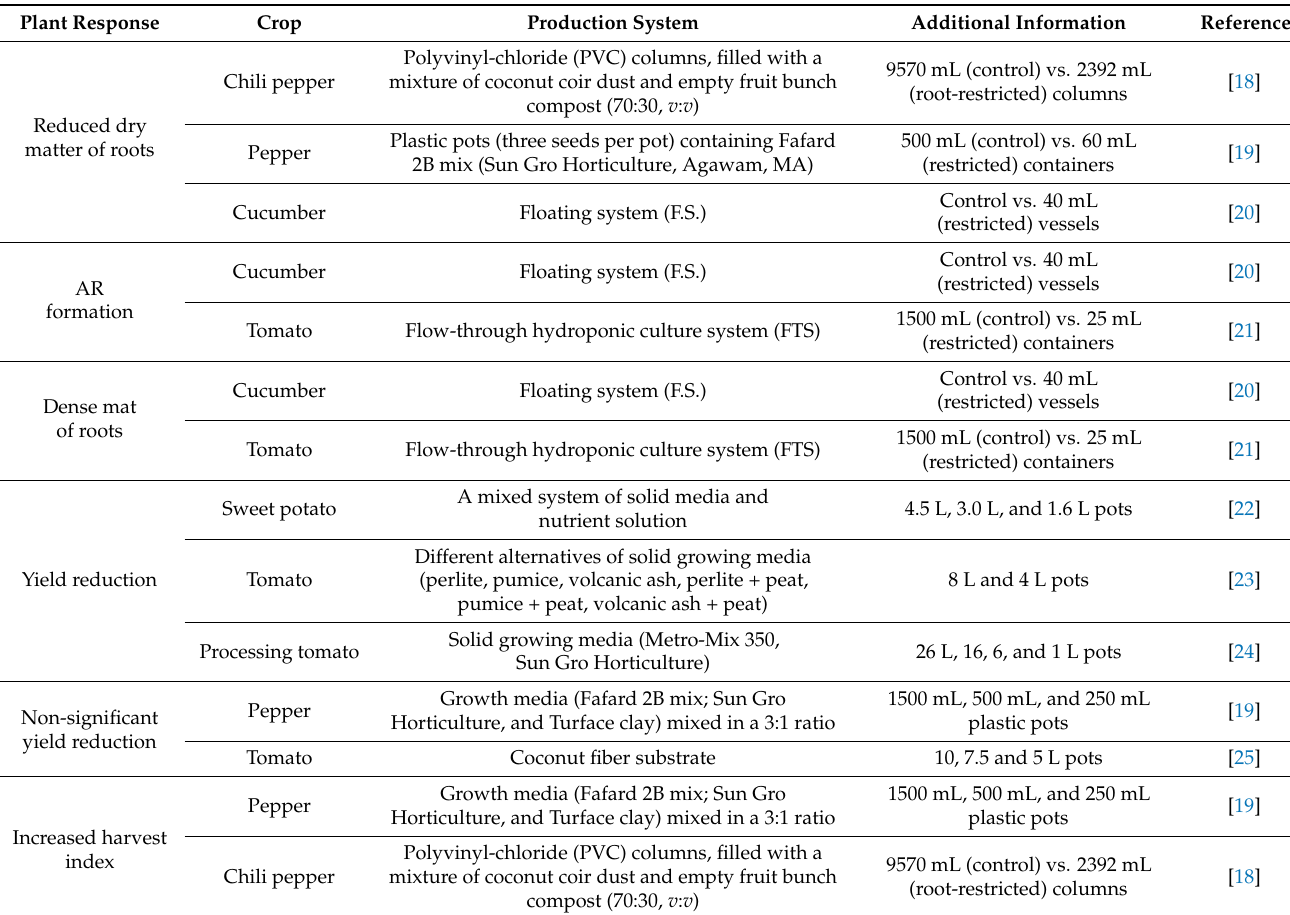
Table 1. Plant responses to root